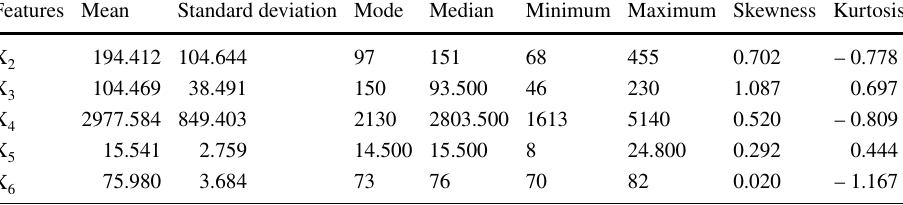
Table 2 Statistical characteristics of the selected dataset (Auto